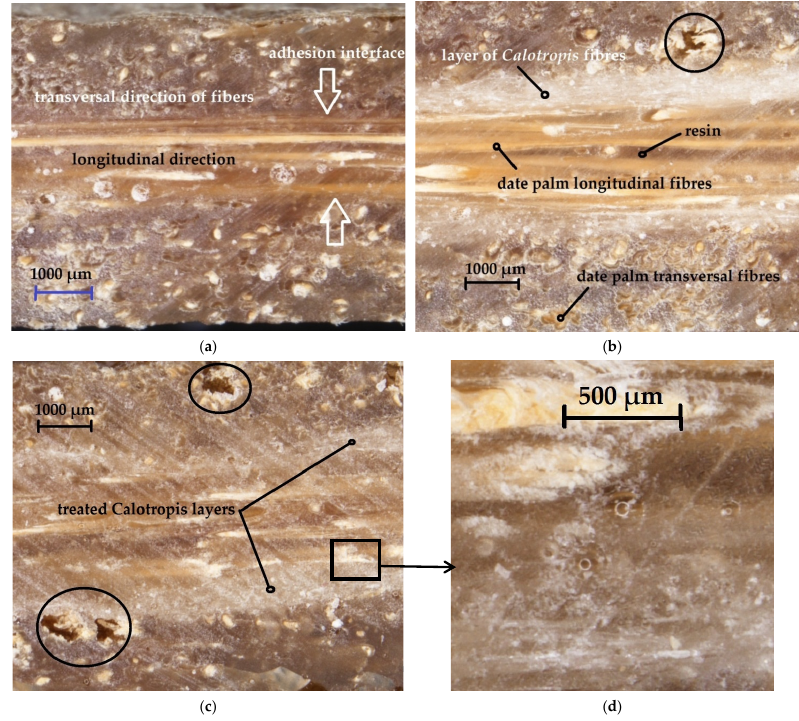
Figure 6. Microscopic investigation of the composite structures: ( a ) D (22.5× magnification); ( b ) DC (22.5× magnification); ( c ) DTC (22.5× magnification); ( d ) detail of the interface between date-palm layer and treated Calotropis layer (60× magnification) marked at ( c ) with black rectangle. The existence of the voids at the interface area located between date-palm fibres and epoxy resin matrix was unveiled also by other researchers in their study [29]. In com- parison, bamboo fibres displayed a better consolidation in the matrix resin and a greater contribution to the mechanical strength. Mixing date-palm fibres with bamboo fibres in an epoxy resin matrix could be the subject of further research, having as an objective the improvement of the mechanical performance of such composite materials. 3.3. FTIR Analysis For the untreated Calotropis fibre (Control), the spectra (Figure 7) presented high absorptions bands at around 3330 cm − 1 , 2910–2800 cm − 1 , 1730 cm − 1 , and several peaks in the fingerprint region (presented in Figure 7), especially in the ranges 1640–1500 cm − 1 and 1370–900 cm − 1 , indicating the presence of the main constituents of lignocellulosic natural materials such as cellulose, hemicelluloses, and lignin, in good accordance with the lit-